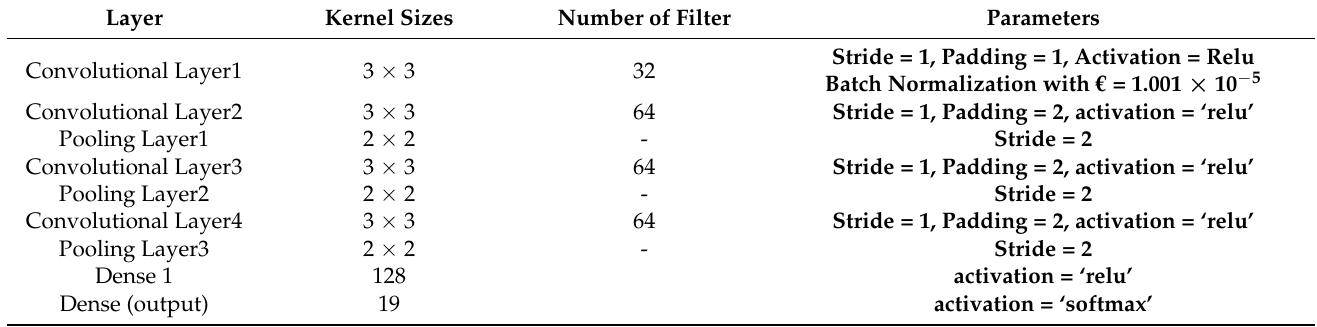
Figure 3. The architecture of the proposed CNN. Table 1. Convolutional and Pooling parameters in the proposed CNN